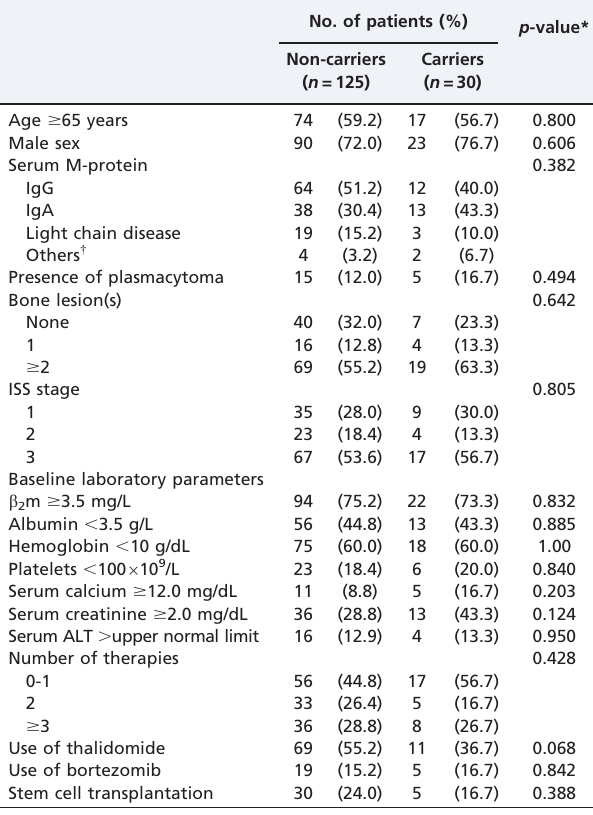
Table 1 - Characteristics of 155 patients with multiple myeloma according to their viral hepatitis carrier